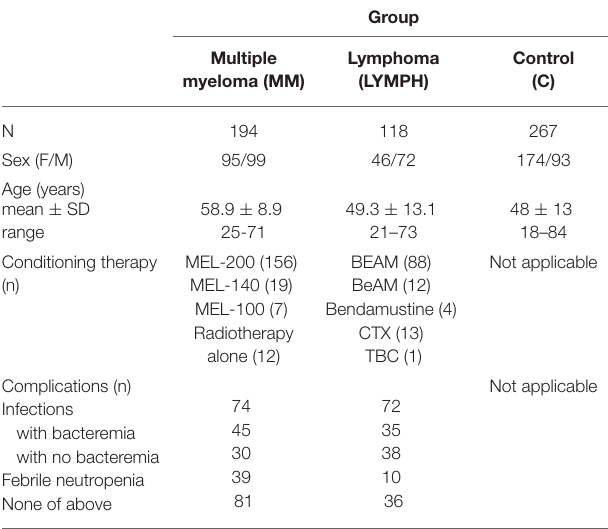
TABLE 1 | Basic characterisation of patients and